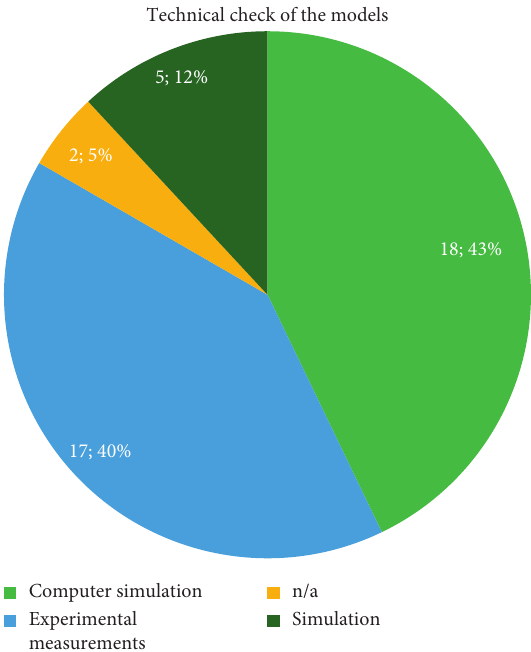
Figure 10: Research distribution by countries with more than one